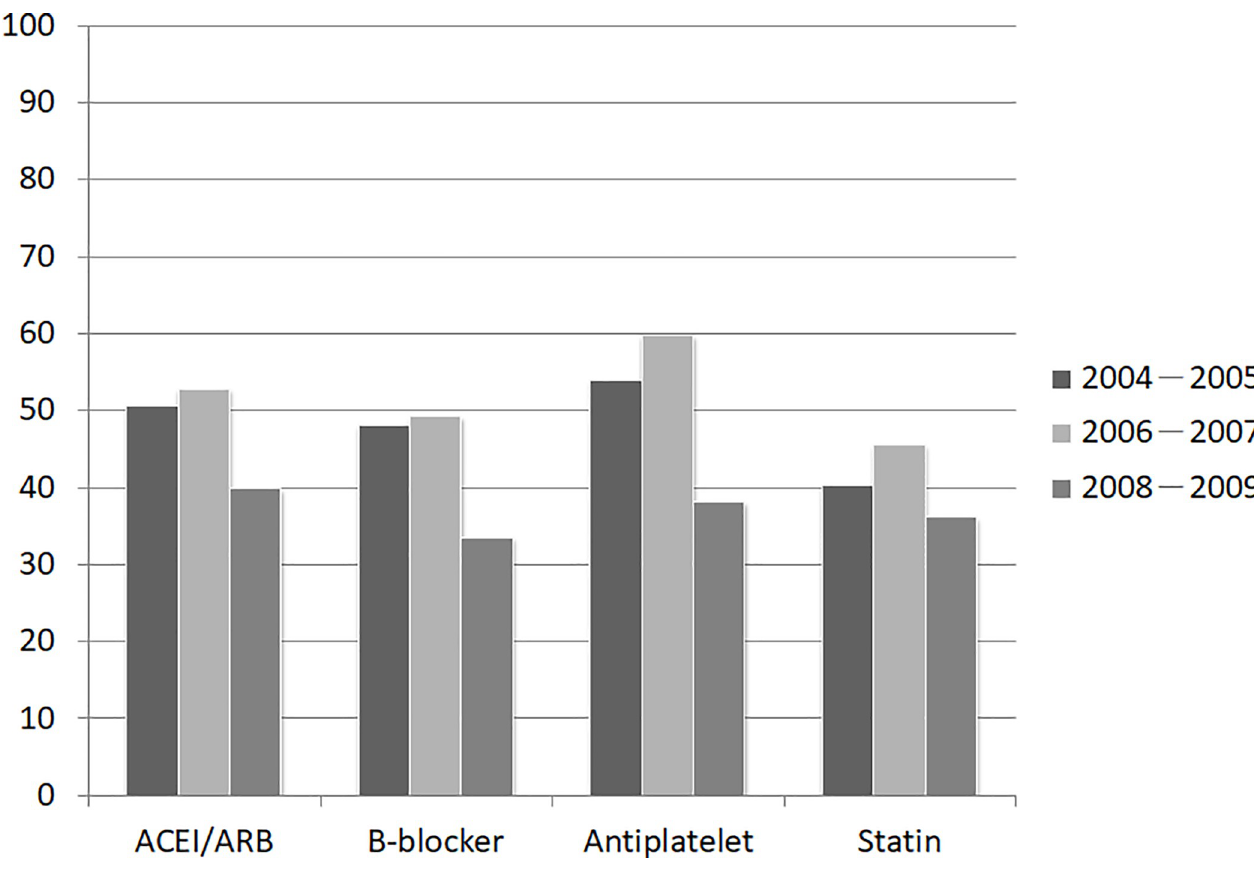
Fig 3. Trend in prescription changes during the follow-up years.